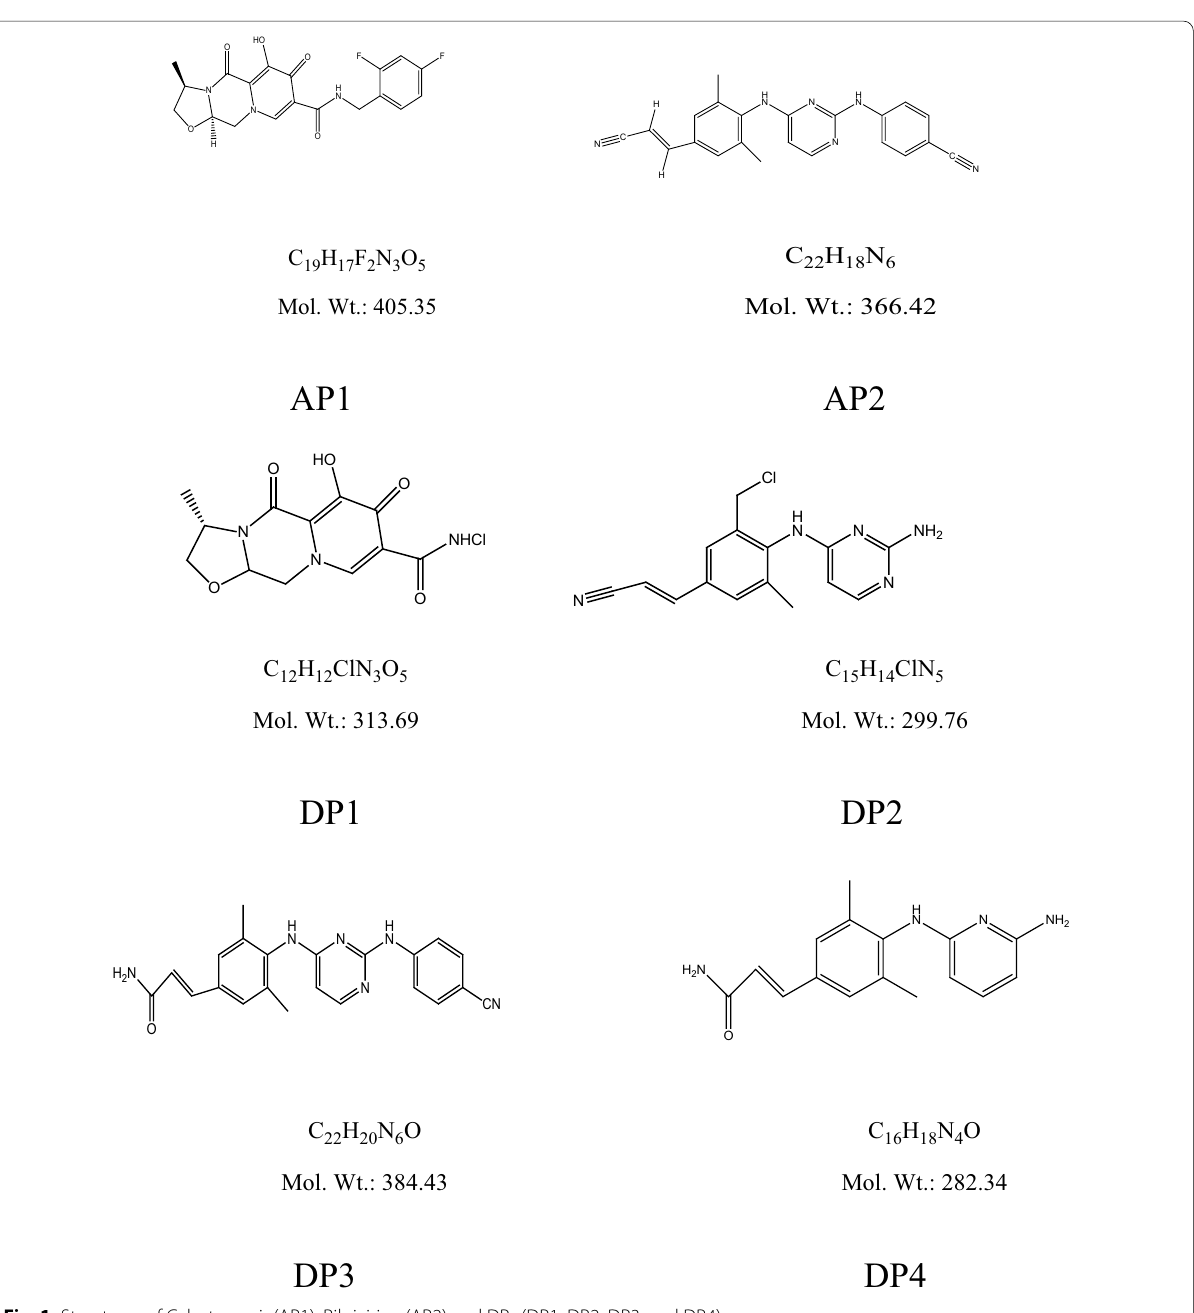
Fig. 1 Structures of Cabotegravir (AP1), Rilpivirine (AP2) and DPs (DP1, DP2, DP3, and